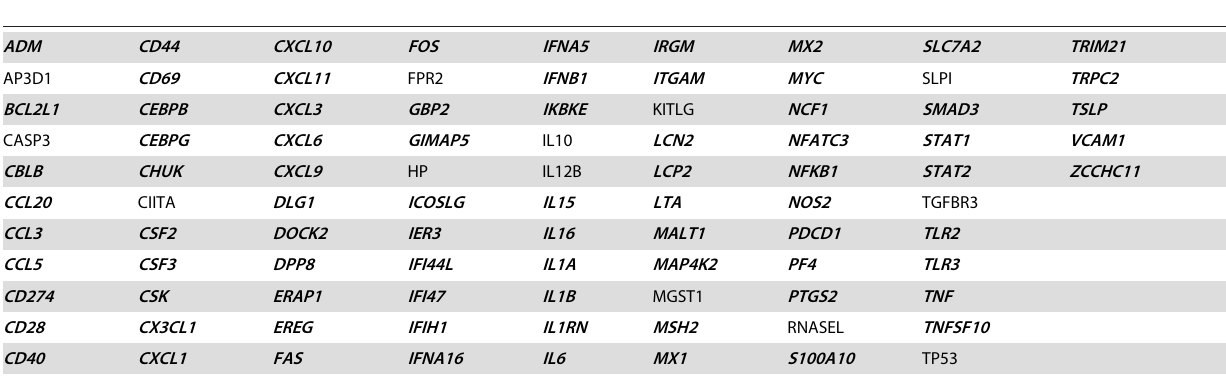
Table 4. Inflammation-related genes that are altered in response to increased expression of miR-146a in LPS stimulated EOC 13.31